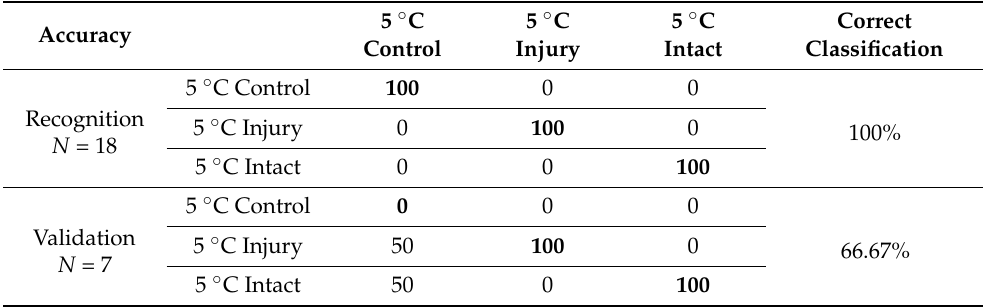
Table 7. LDA classification model on the e-tongue data of control and infected plum juices stored at 5 ◦ C with second parallel sample validation when the inoculation mode was used as class variable ( N = 25).